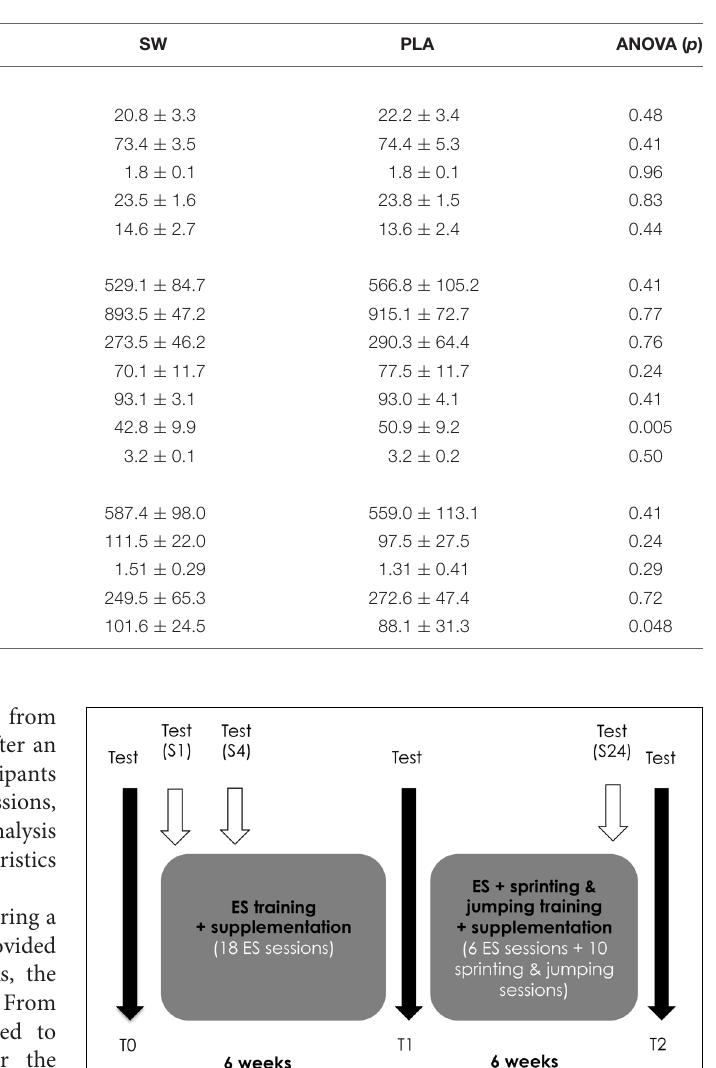
TABLE 1 | Baseline characteristics.